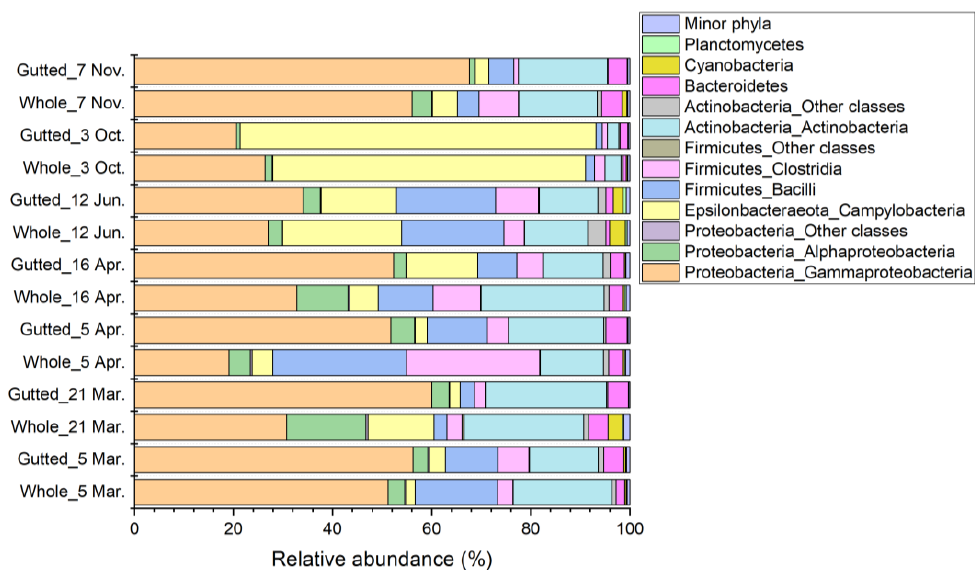
Figure 4. Bacterial population composition of the whole and gutted herring at the class-phylum level as identified with 16S rRNA gene amplicon sequencing. Each batch is an average of four to six whole and gutted fish.